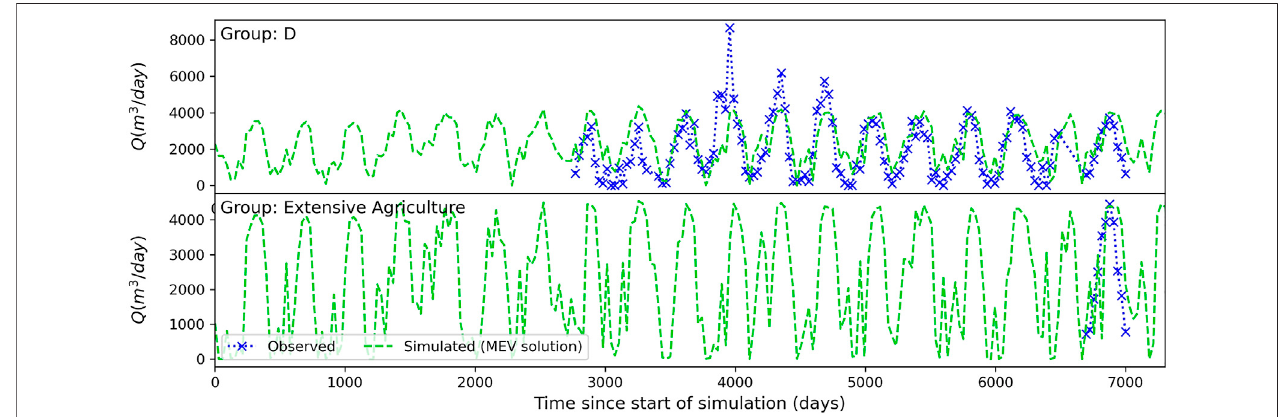
FIGURE 6 | Measured and simulated extraction rates for user group D, and the extensive agriculture group.